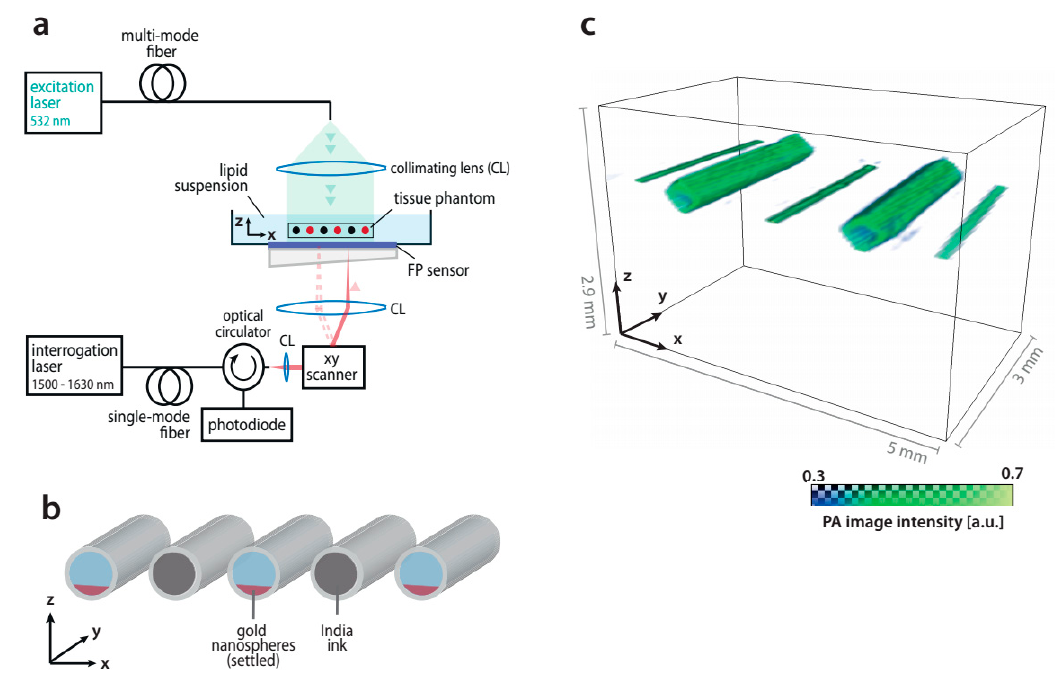
Figure 1. ( a ) Schematic of the experimental setup. The tissue phantom was placed on the Fabry ‐ Pérot sensor and illuminated from the top by the output of the excitation laser. ( b ) Schematic of the tissue phantom, which consisted of parallel polymer tubes filled with either gold nanospheres (diameter 150 nm) or diluted India ink. The gold nanospheres were allowed to settle before the PA imaging was performed. ( c ) 3D photoacoustic (PA) image of the phantom acquired at a fluence of 17.8 mJ/cm 2 .